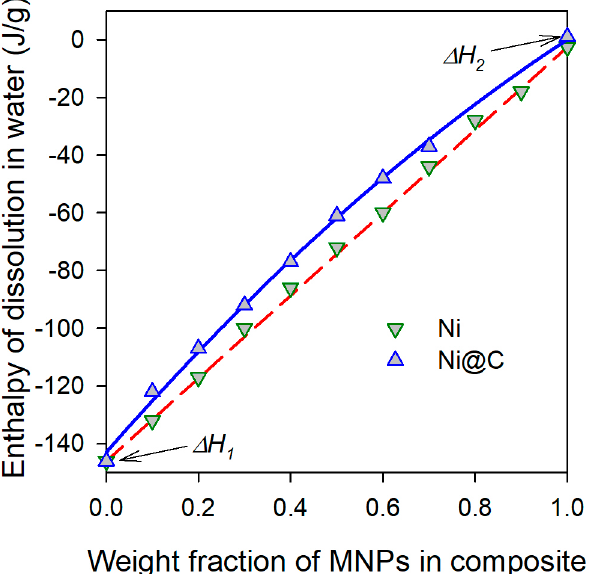
Figure 7. Enthalpy of dissolution of Na-alginate + MPs composites in water ( Δ H 4 ) at 25 °C. Values at the ordinate axes correspond to the enthalpy of dissolution of Na-alginate (left axis— Δ H 1 ) and to the enthalpy of wetting of MNPs (right axis— Δ H 2 ). Experimental data for Ni and Ni@C are presented.